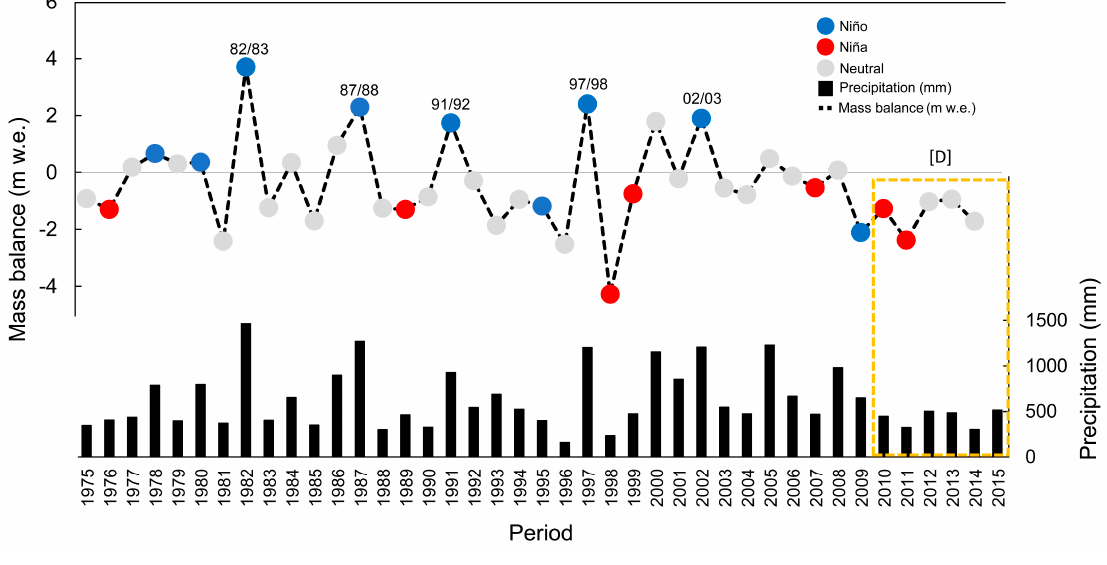
Figure 5. Comparison of the annual mass balance of the Echaurren Norte Glacier between 1975–2015 and annual precipitation between 1975 and 2015 at El Yeso station (black bars). El Niño–Southern Oscillation (ENSO) 3.4 region data were retrieved from the National Ocean and Atmospheric Administration (NOAA). Drought period [D] in orange box [12].